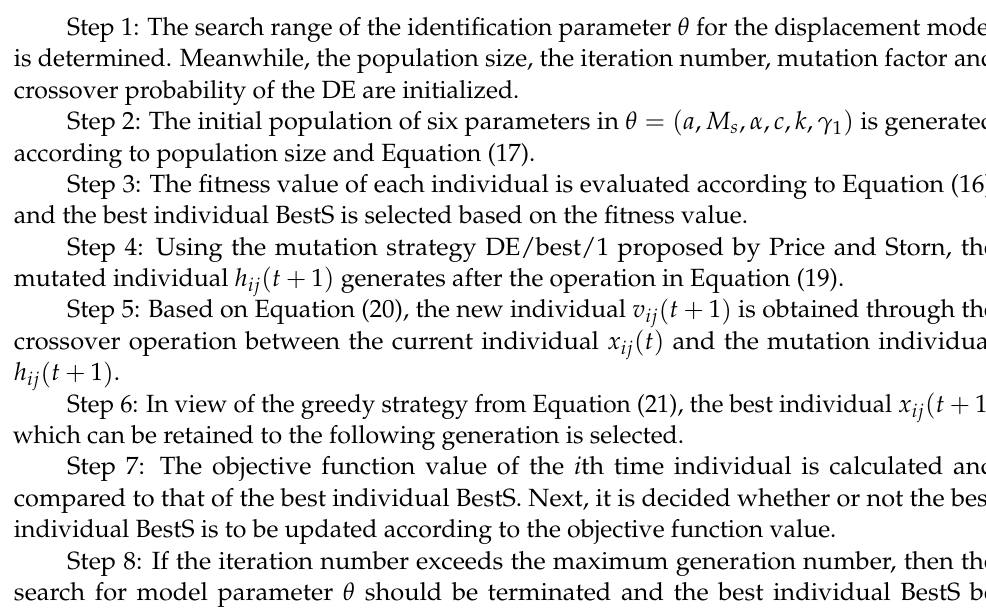
Figure 3. Flow chart of parameter identification using DE.